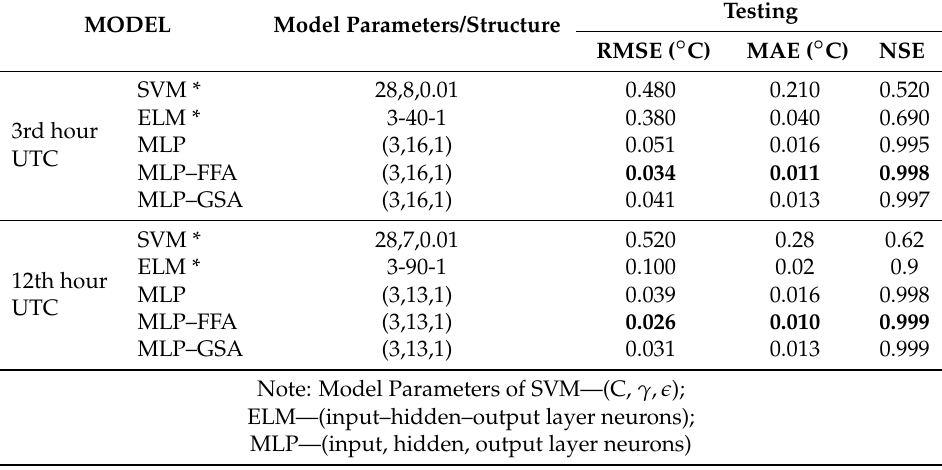
Table 4. The performance of the computed metrics for Bajpe station.